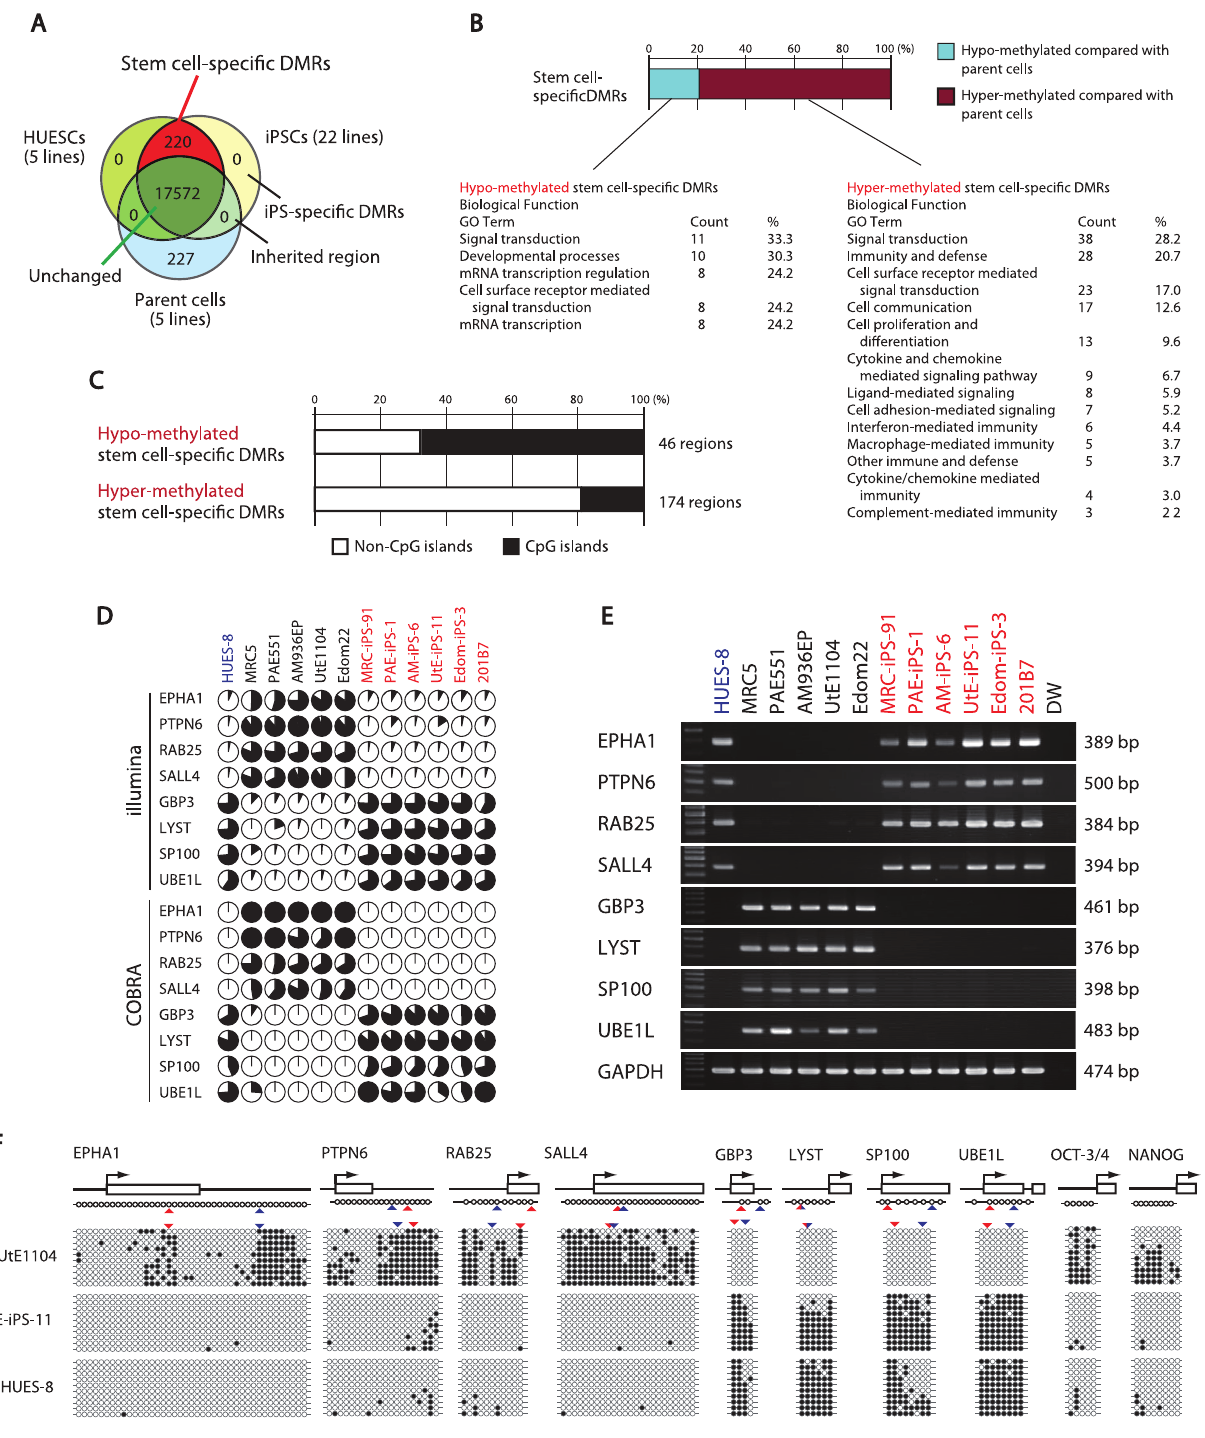
PLoS Genetics | www.plosgenetics.org